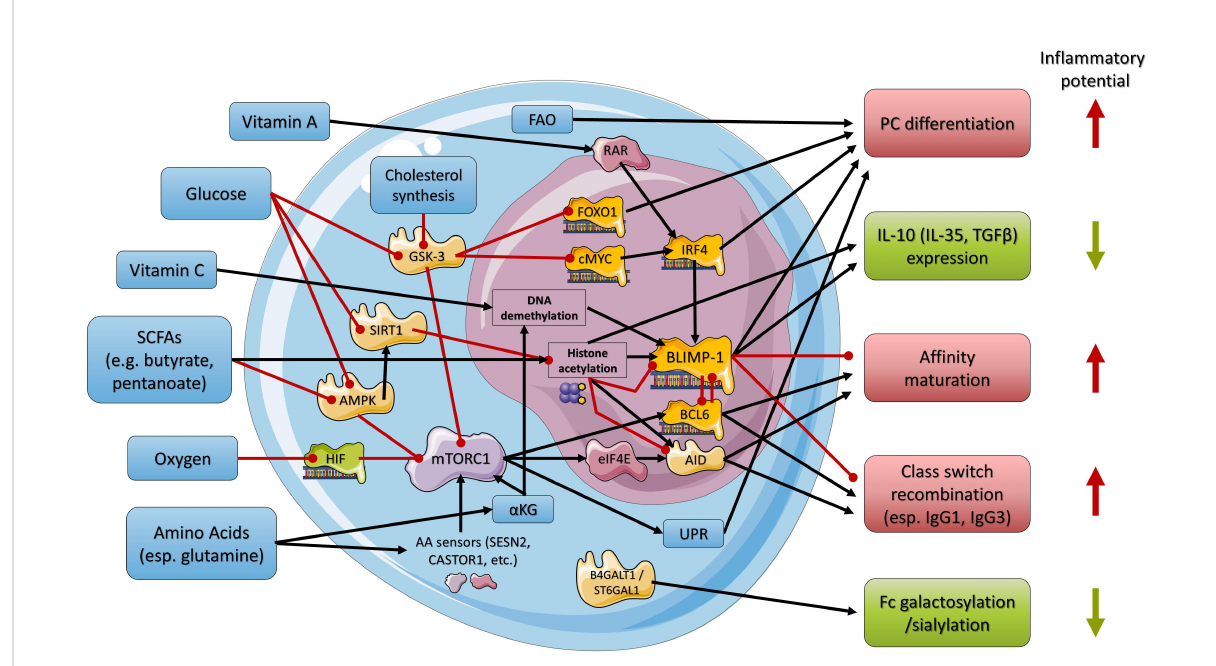
FIGURE 1 Simpli fi ed overview of the regulatory network used by nutrients and metabolites in regulating B cell maturation and PC differentiation and function. Black arrows indicate stimulation, and red arrows indicate inhibition. Nutrients, metabolites, and related cellular processes are indicated in blue, enzymes in light yellow, transcriptional regulators in orange, and other proteins in shades of purple. Anti- or proin fl ammatory outcomes of regulatory processes are indicated in green or red, respectively. AID, activation-induced cytidine deaminase; a KG, a -ketoglutarate; AMPK, AMP-activated protein kinase; B4GALT1, beta-1,4-galactosyltransferase 1; BCL6, B-cell lymphoma 6; BLIMP-1, B lymphocyte-induced maturation protein-1; cMyc, MYC proto-oncogene; eIF4E, eukaryotic translation initiation factor 4E; FAO, fatty acid oxidation; FOXO1, Forkhead-Box-Protein; O1GSK-3, glycogen synthase kinase 3; HIF, hypoxia-inducible factor; IRF4, interferon regulatory factor 4; mTORC1, mammalian (mechanistic) target of rapamycin complex 1; RAR, retinoic acid receptor; SIRT1, sirtuin 1; ST6GAL1, beta-galactoside alpha-2,6- sialyltransferase 1; UPR, unfolded protein